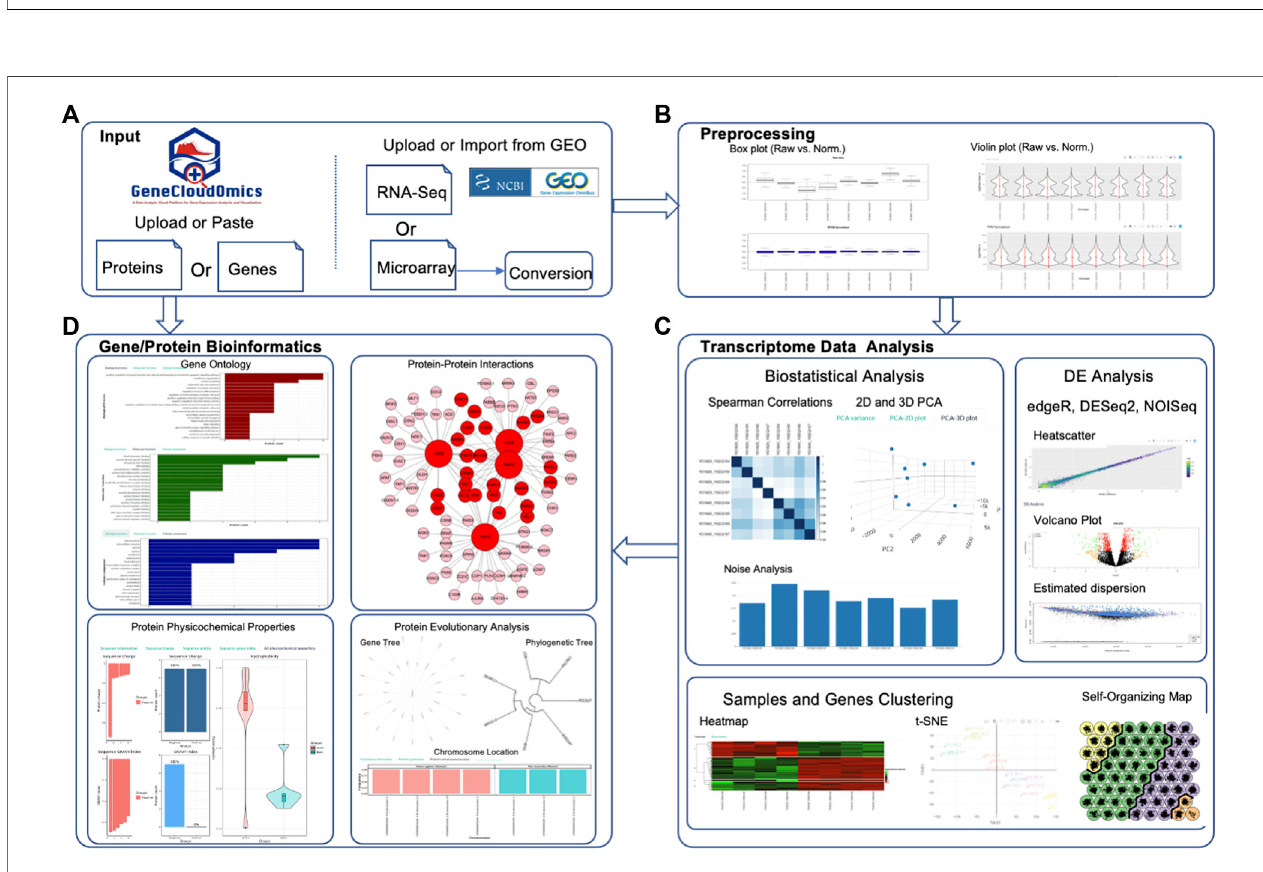
FIGURE2| SchematicOverviewofGeneCloudOmics. (A) RNASeqandMicroarraydatauploading, (B) DataPre-processing, (C) TranscriptomeDataAnalysis(e.g. Correlation, DGE analysis and heatmap clustering), and (D) Gene or Protein Bioinformatics Analysis.